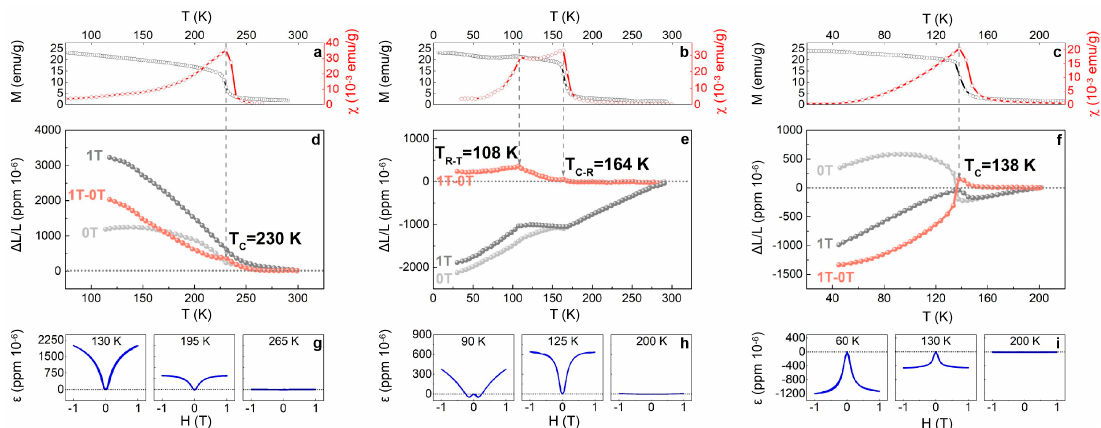
Figure 3. (Color online) ( a – c ) Temperature spectra of magnetization (M) and magnetic susceptibility ( χ ) of TbCo 2 , Tb 0.3 Dy 0.7 Co 2 , and DyCo 2 ; ( d – f ) the thermal expansion under 1 Tesla, 0 Tesla, and the subtraction of these two (1T–0T) of TbCo 2 , Tb 0.3 Dy 0.7 Co 2 , and DyCo 2 ; ( g – i ) the magnetostriction curves of TbCo 2 , Tb 0.3 Dy 0.7 Co 2 , and DyCo 2 at different temperatures.